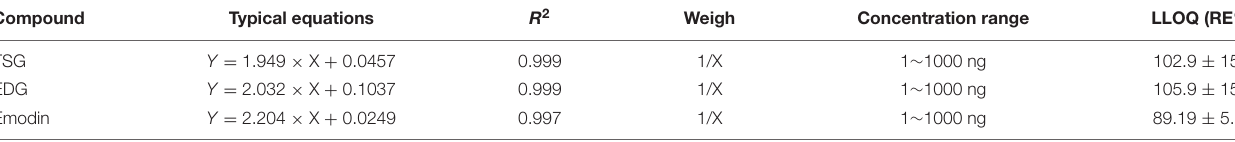
TABLE 2 | The calibration curves for TSG, EDG, and emodin. Compound Typical equations R 2 Weigh Concentration range LLOQ (RE%) TSG